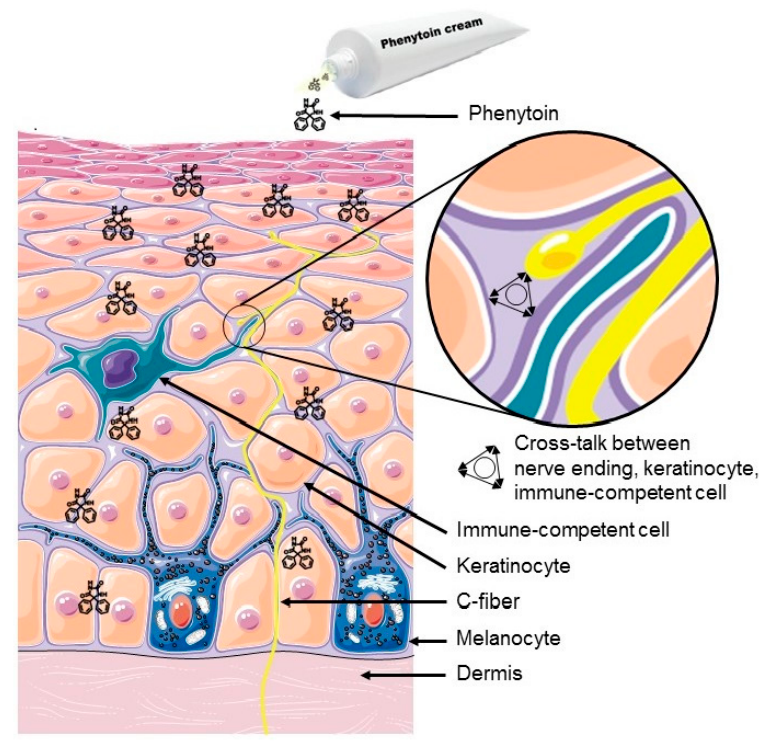
Figure 1. Cross-talk between nerve ending, keratinocyte, and an immune-competent cell.